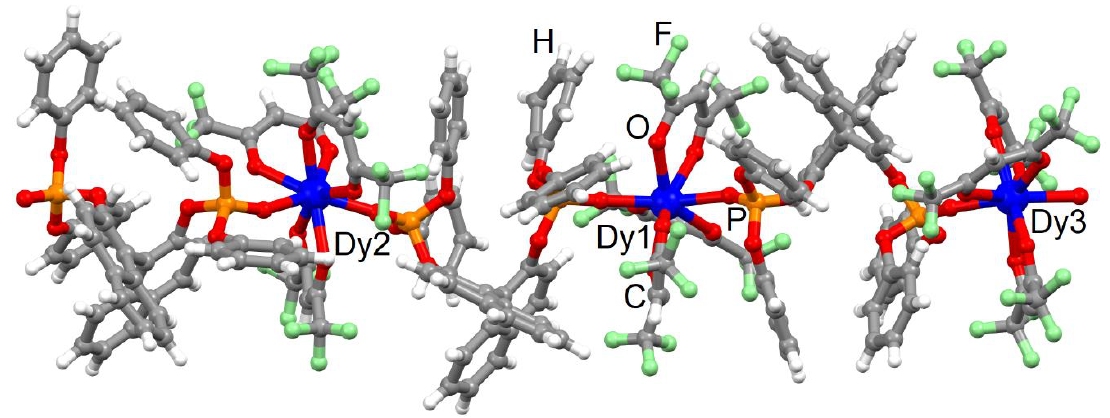
Figure 1. Asymmetric unit for the complex [(Dy(hfac) 3 (( S )-L)) 3 ] n ( 1 ). Dy = blue, O = red, C = grey, P = orange, F = green and H = white.